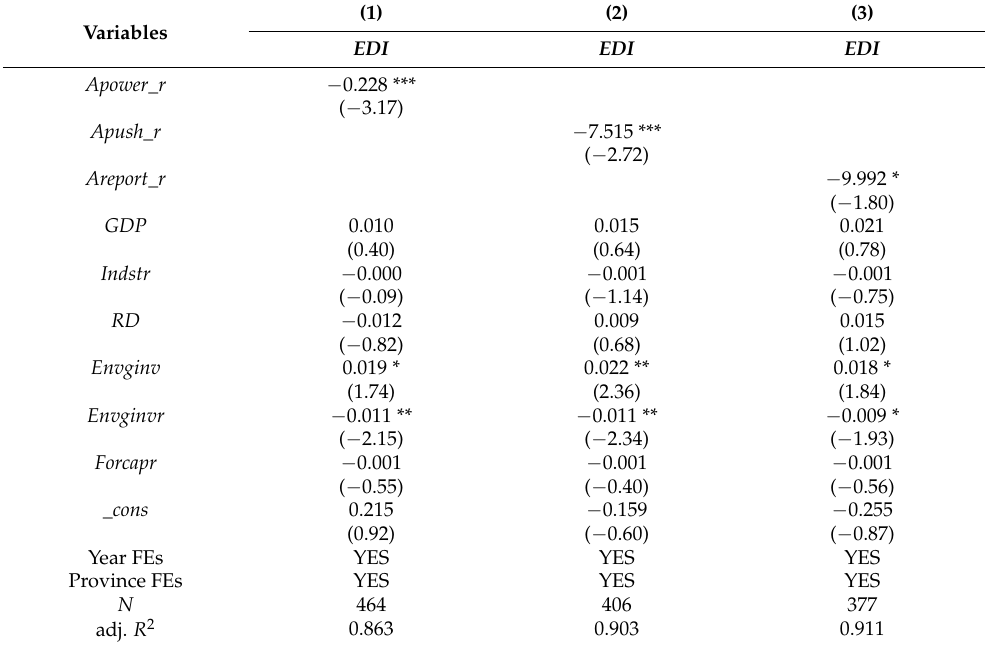
Table 9. Replacing indicators for government environmental auditing.